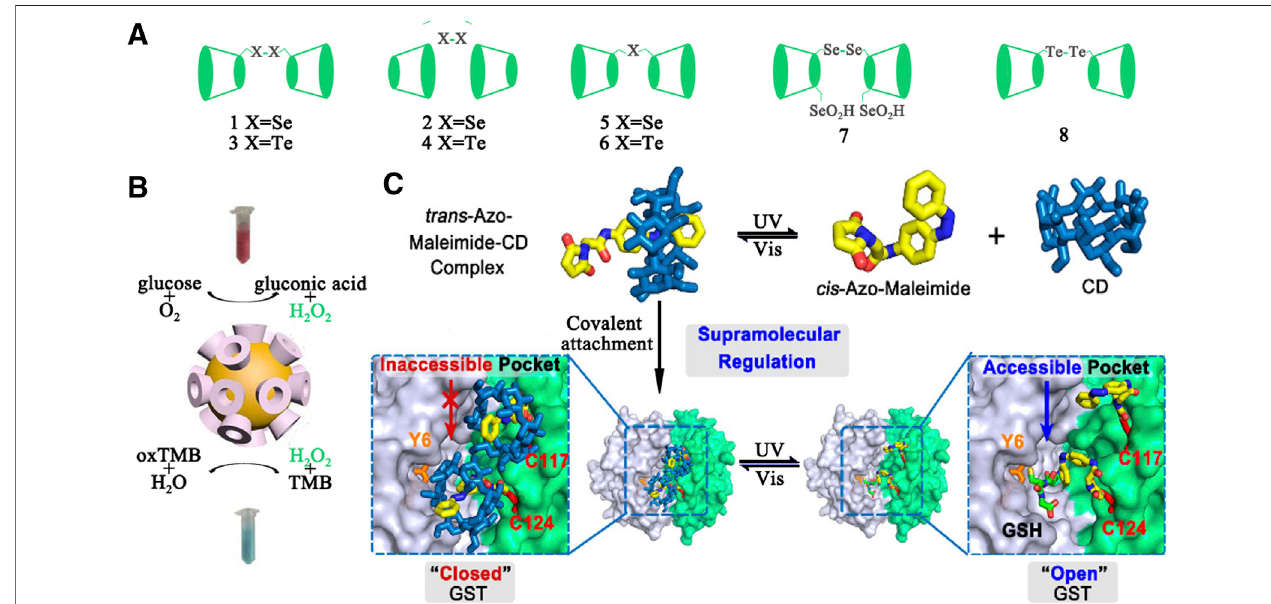
FIGURE 5 | (A) CD-based arti fi cial enzymes. (B) Illustration of the cascade catalysis system using the -CD@AuNPs as the only catalyst. (C) Illustration of the optically controlled supramolecular switch for Glutathione S-Transferase (GST).